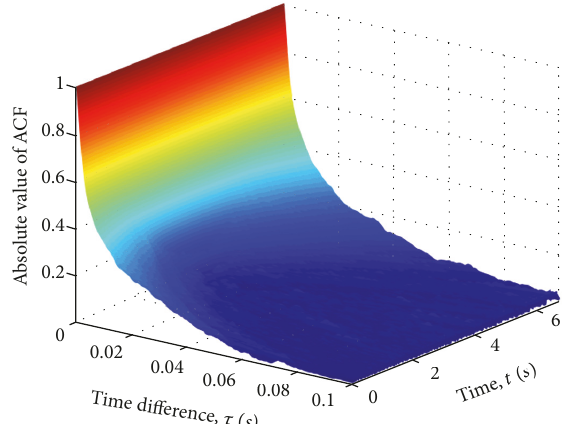
Figure 3: Absolute values of the theoretical TV-ACF |𝑟 𝑝𝑞 (𝑡, 𝜏)| ( 𝐾 𝑝𝑞 = 0).